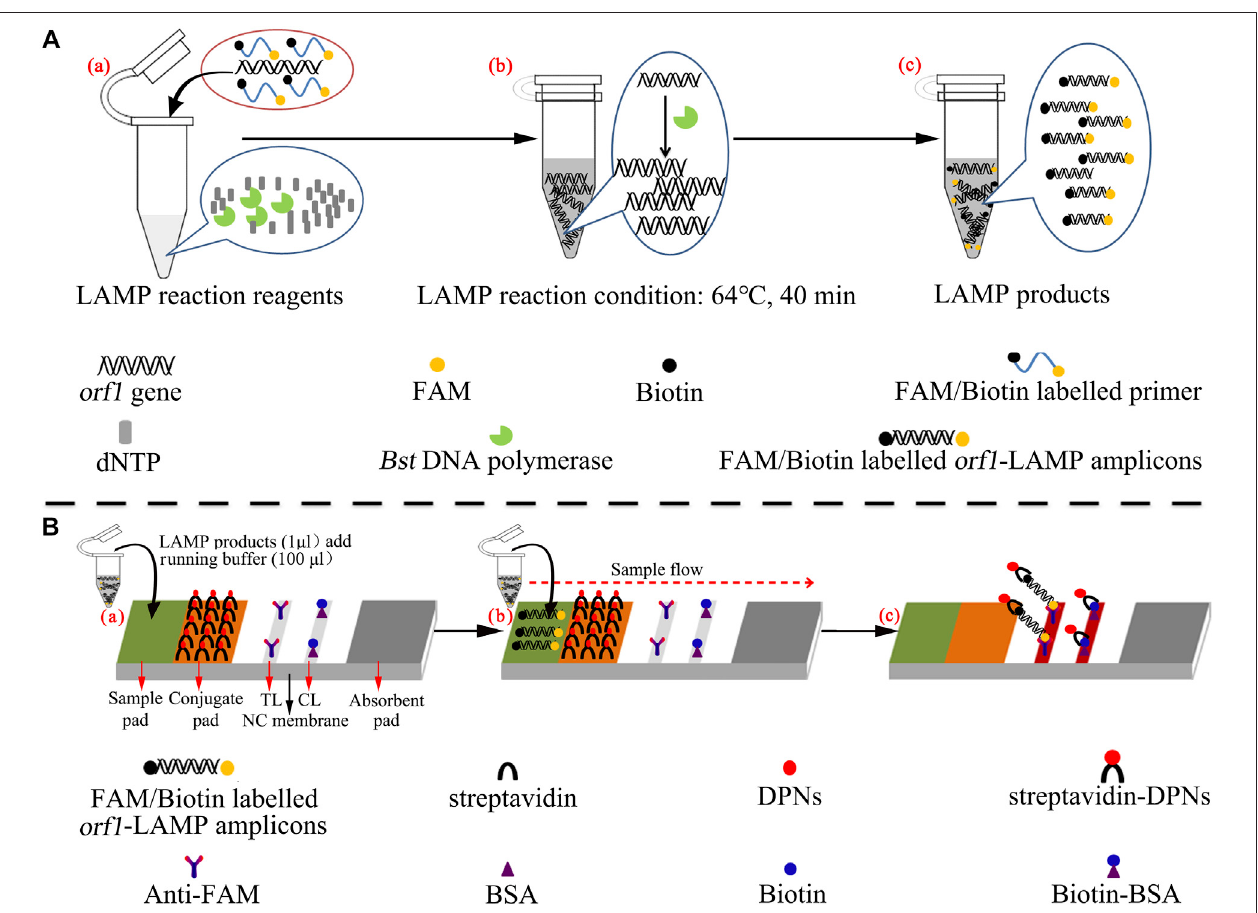
FIGURE 1 | Mechanistic description of N. gonorrhoeae -loop-mediated isothermal ampli fi cation linked to a polymer nanoparticle – based biosensor (LAMP-PNB) assay. (A) Process of N. gonorrhoeae -LAMP. (B) Schematic illustration of the principle of the polymer nanoparticle – based biosensor assay for visualization of N. gonorrhoeae -LAMPproducts.Apositiveresult fortheorf1genemeans thatthetest line(TL) andcontrolline(CL)appear simultaneouslyonthebiosensor.Onlyacontrol line (CL) appearing on the biosensor indicates a negative result. dNTP: deoxynucleotide triphosphate; FAM: carboxy fl uorescein; DPNs: dye (crimson red) –